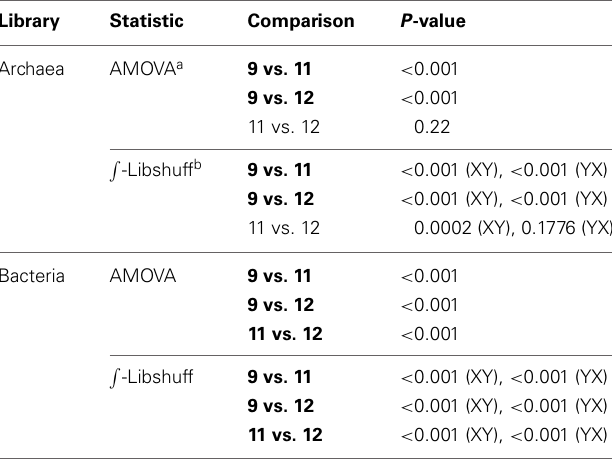
Table 3 | Community comparisons among ponds for 16S rRNA sequence